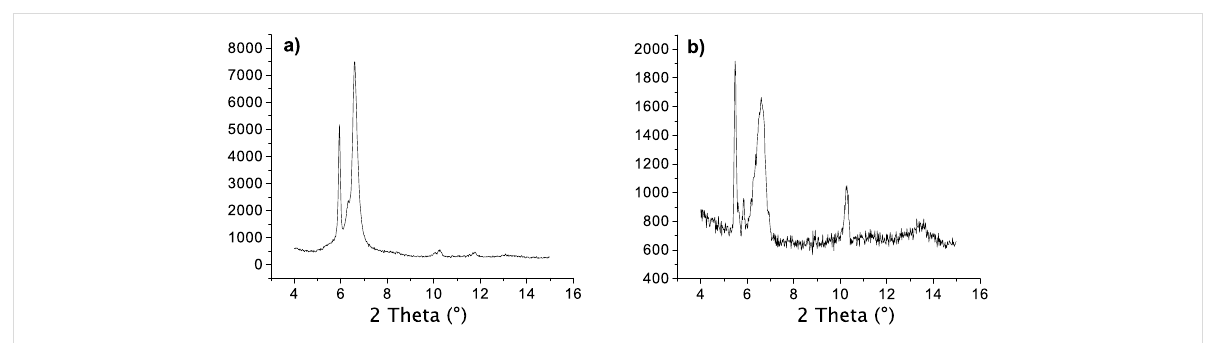
Figure 9: X-ray powder diffractograms of (a) ( S,R )- 1b and (b) ( S,S )- 1b xerogels prepared from their toluene